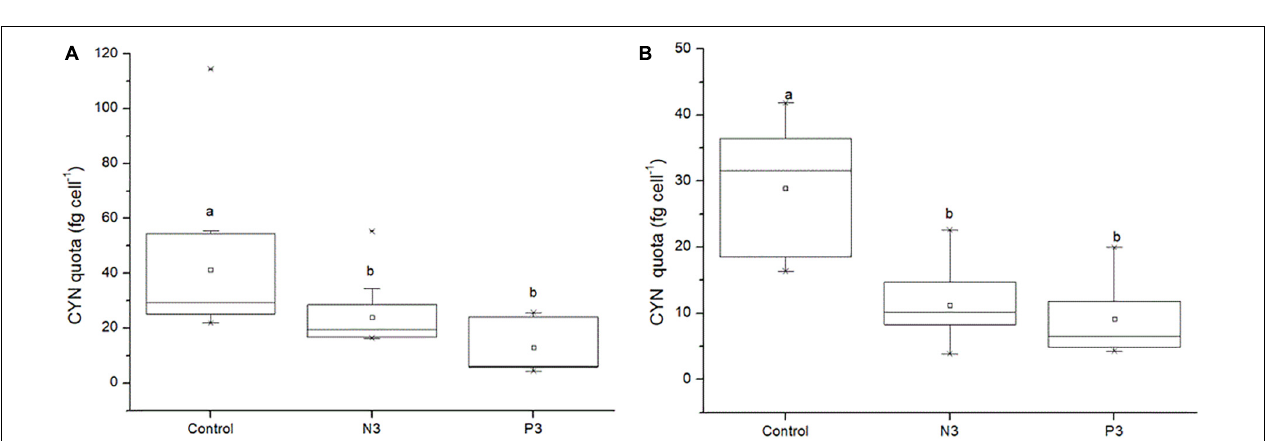
FIGURE 7 | Changes in cell concentrations of toxic ( cyrJ copy numbers) and non-toxic (the differences between rpoC1 and cyrJ copy numbers) R. raciborskii , and proportion of toxic and non-toxic strains under P-limited (P3) condition. Panels (A,C) showed data for QDH7/N8 co-culture experiments, whereas panels (B,D) showed data for CS506/CS510 co-culture experiments. These experiments were started with equal amounts of CYN-producing and non-CYN-producing cells (1:1, blue dotted line in panels (C,D) ).